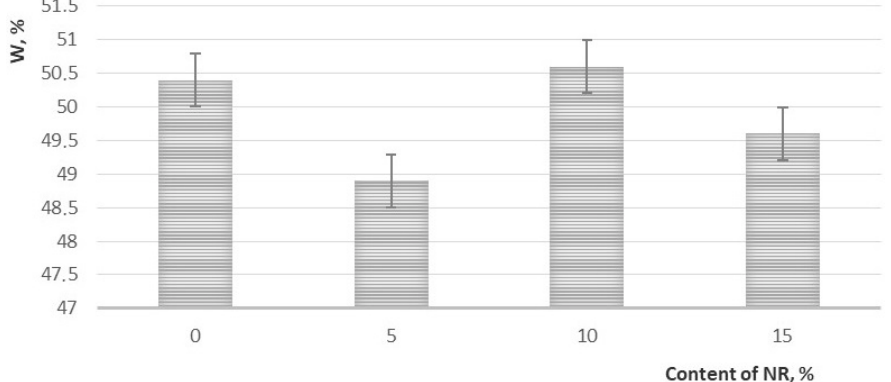
Figure 3. Degree of water absorption (W, %) of samples of nonwoven PLA/NR fiber containing 0, 5, 10, and 15 wt.% of NR.